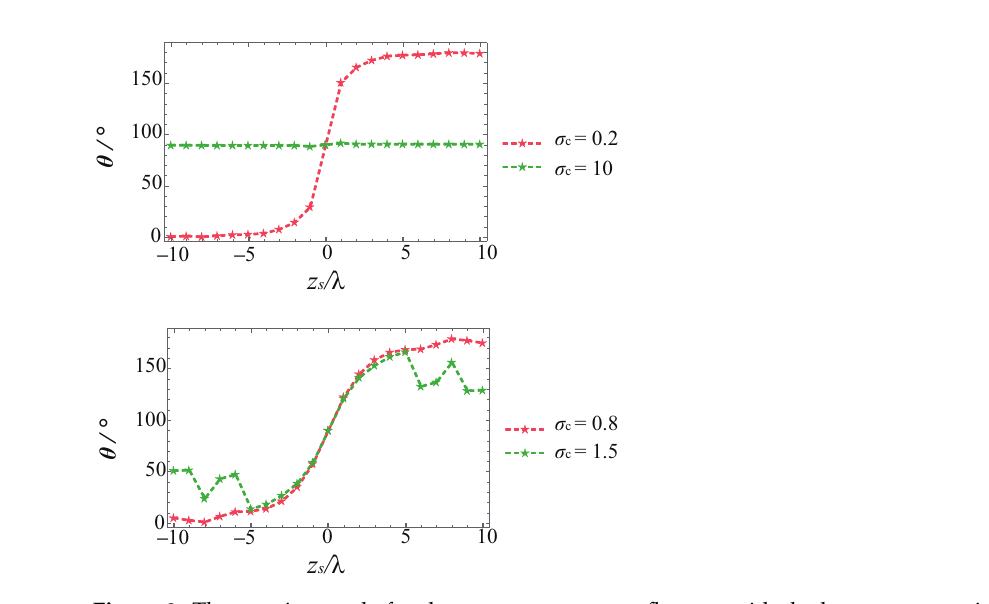
Figure 9. The rotation angle for the transverse energy flux s xy with the beam propagation. Here, a = 0.5 w 0 , f = 2 mm, w 0 = 2 mm and α = 60 ◦